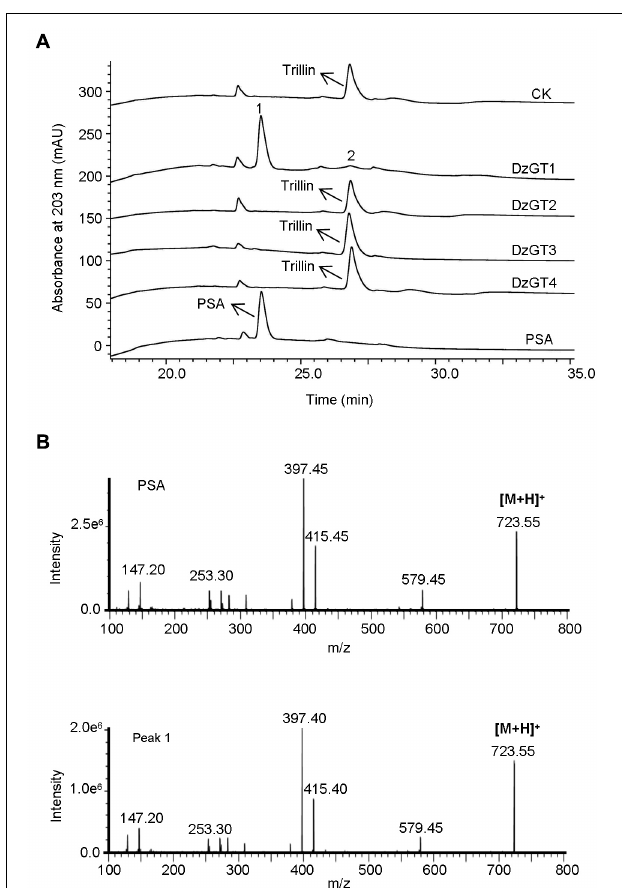
FIGURE 3 | HPLC and LC-MS analysis of the enzyme activities of the purified recombinant DzGTs to trillin i n vitro . (A) The enzyme activity of the recombinant DzGT1 was shown for the conversion of most trillin to prosapogenin A of dioscin (PSA) (peak 1) and a little trillin (peak 2) unconverted. Compared to the control, no new product peak was detected when DzGT2-DzGT4 were assayed. (B) The mass spectra of the peak 1 with its corresponding authentic standard